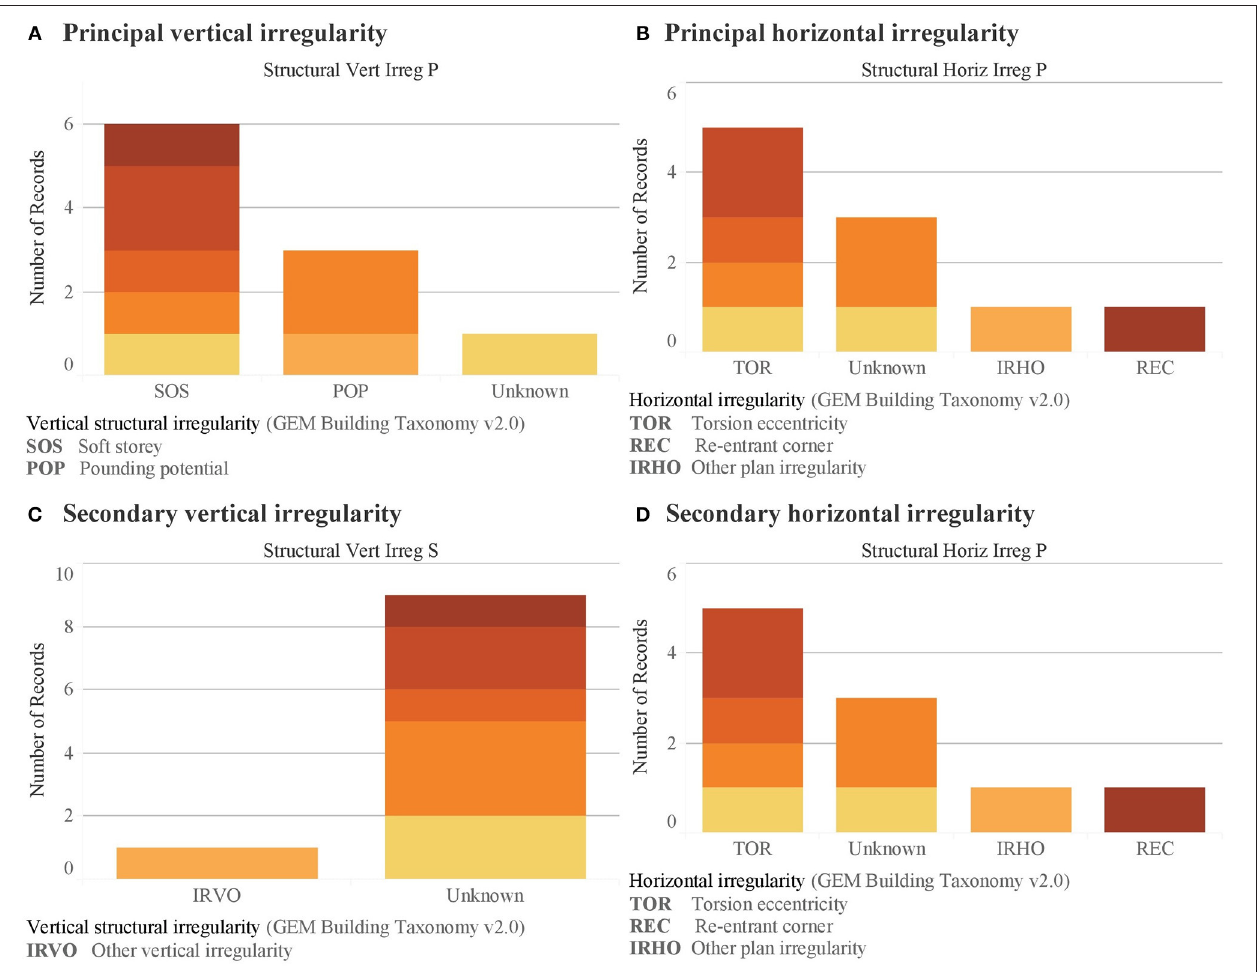
FIGURE 10 | Dashboard showing irregularities in buildings. Principal vertical (A) and horizontal (B) irregularities. Secondary vertical (C) and horizontal irregularities.